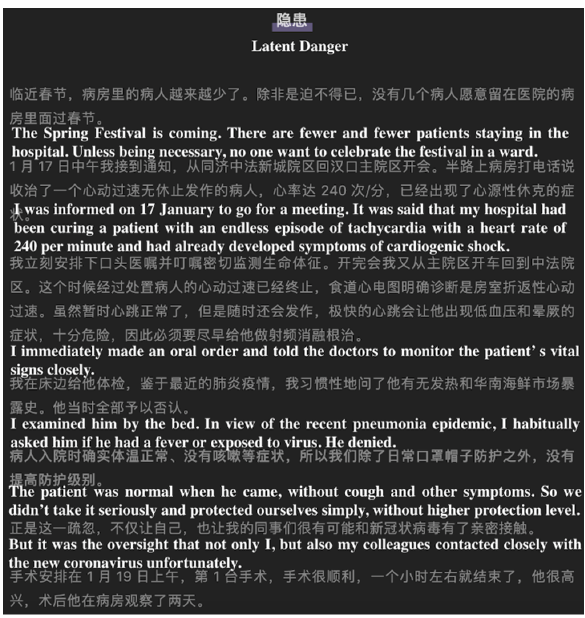
Figure 7. Screenshot of a story type. From: Ning Zhou. A Wuhan doctor was suspected of being infected. He recovered after 4 days’ isolation at home! Please spread his life-saving strategy to everyone.